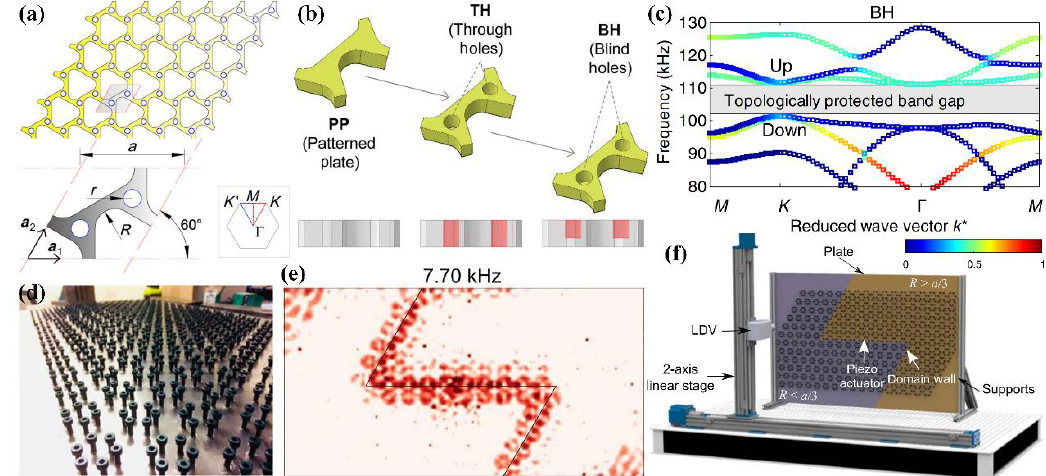
Figure 2. Analogue spin Hall insulators. ( a ) The elastic plate and the zoomed-in view of the unit cell. The inset presents the high-symmetry points Γ , K , K (cid:48) , M of the first irreducible Brillouin zone. [61]. ( b ) The schematic of three types of unit cell with distinct holes [61]. ( c ) Dispersion curve for the plate with blind holes. The colors ranging from blue to red suggest that from pure in-plane modes to pure out-of-plane modes [61]. ( d ) The experimental configuration [63]. ( e ) The edge-state transmission along the domain wall at 7.70 kHz frequency [63]. The color represents the power spectral density, which is calculated from the measured out-of-plane velocity of the plate. ( f ) The experimental setup, in which a piezoelectric actuator is positioned at the center to excite the plate, and out-of-plane velocity is measured point-by-point by an LDV (Polytec OFV 534 laser Doppler vibrometer) mounted on a two-axis linear stage [63].